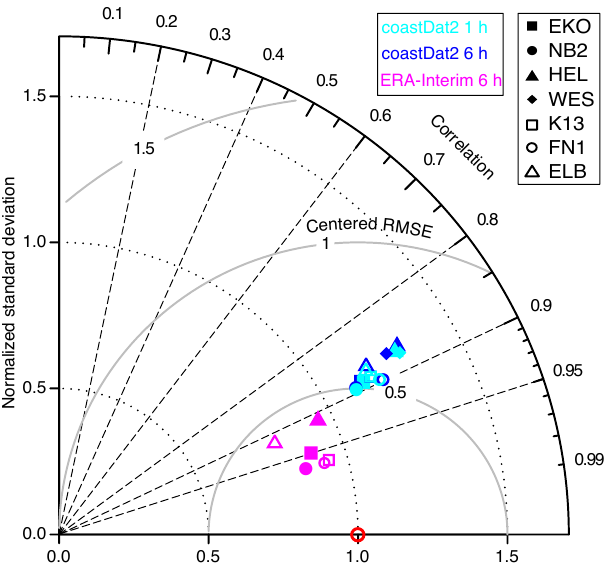
Figure 3. Normalized Taylor diagram from 1h (cyan) and 6h (blue) coastDat2 SWHs and from 6h ERA-Interim (magenta) SWHs at seven (coastDat2) and at six (ERA-Interim) observational sites. The red circle represents a perfect model compared to the